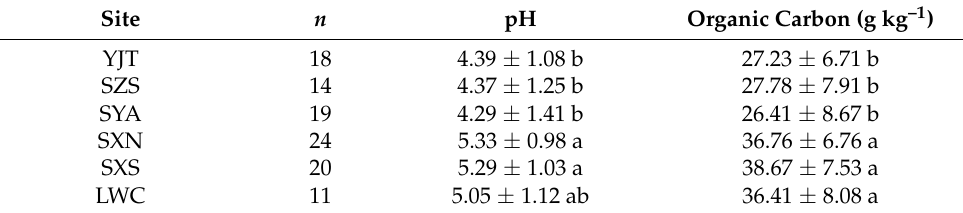
Table 1. Properties of the soils from the six sampling